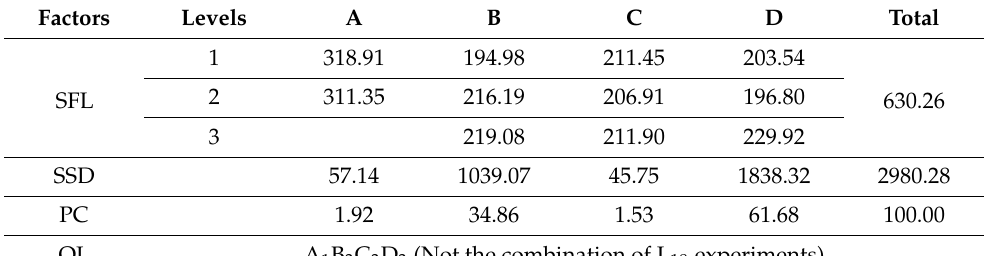
Table 10. Pareto ANOVA results for tool wear rate